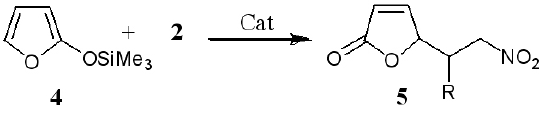
70/30 Scheme 2. Conjugate addition of 6 to nitroalkenes 2 . a All the yield refer to isolated, chromatographically pure compounds whose structures were assigned by analytical and spectroscopic data. b Diastereoisomeric ratios were determined by 1 H NMR analysis (400 MHz) on the crude products. c The reaction was performed in CH Cl 2 2